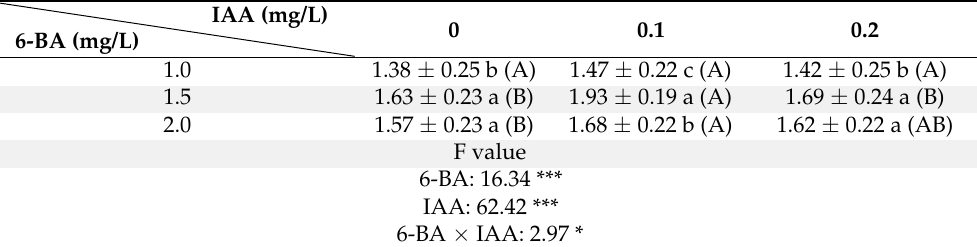
Table 11. Effect of NAA on rooting of adventitious shoot.